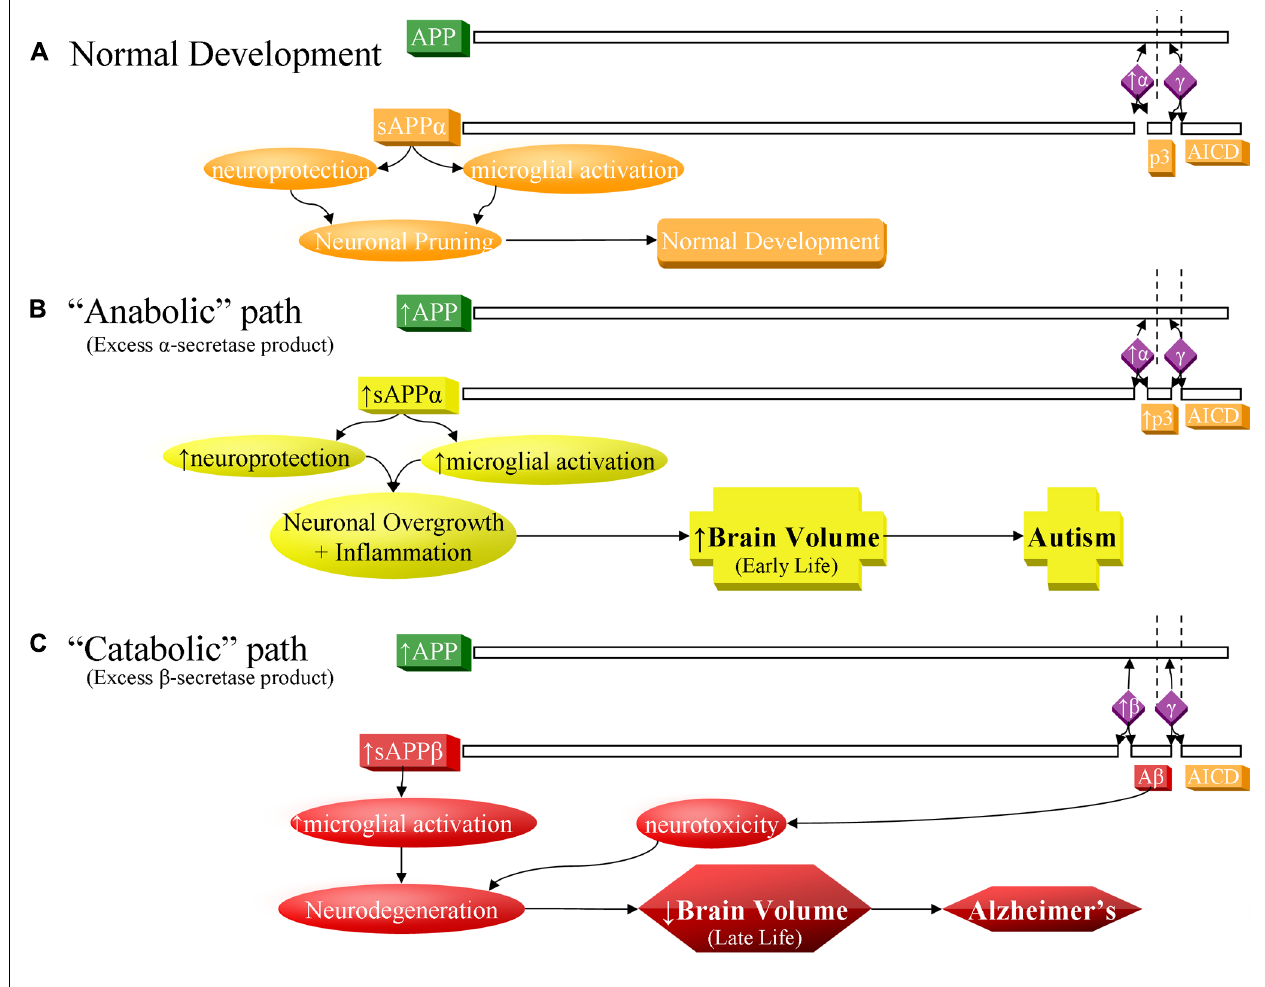
FIGURE 1 | Contrast of normal and pathogenicAPP protein processing pathways. (A) Normal pathway. APP protein (green) is processed by secretases (violet) and usually cleaved at the α -secretase site by ADAM10 or ADAM17 ( α ), then afterwards by the γ -secretase complex ( γ ).This produces sAPP α , the non-pathogenic p3 peptide product, and the APP intracellular domain (AICD).The sAPP α product is both neuroprotective and activates microglia.These balanced processes, under normal conditions, lead to neural pruning and normal development at appropriate times.This is the majority APP processing pathway. (B) APP anabolic dysfunction of the α -secretase pathway, specifically anabolic proteins/peptide levels, processes, and outcomes indicated in yellow. Overproduction of APP and/or excess α -secretase activity results in overproduction of sAPP α , which both